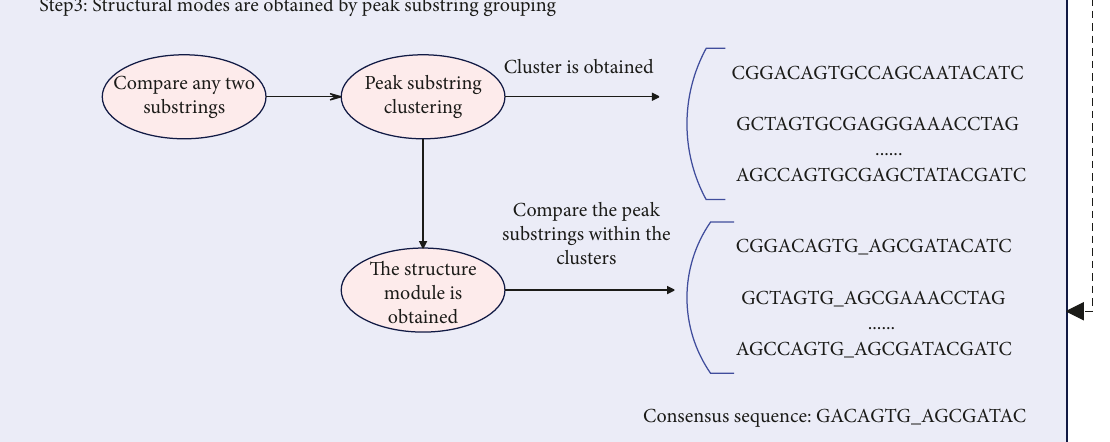
Figure 3: Schematic diagram of SMS